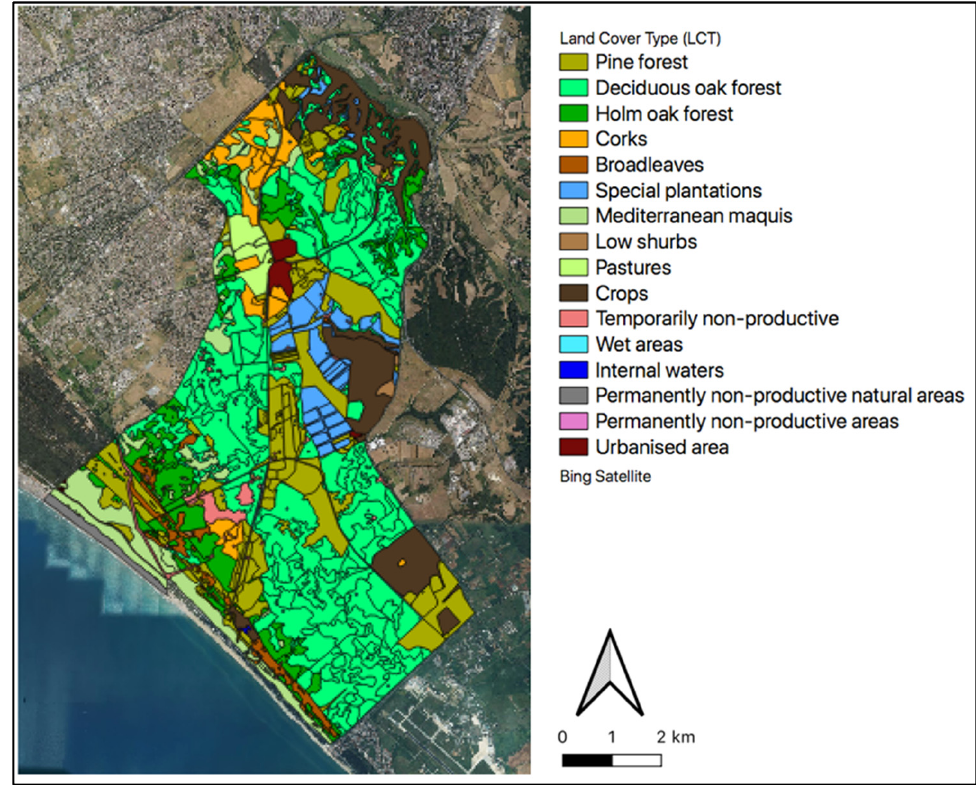
Figure 1. Vegetation map of the presidential Estate of Castelporziano, colored contours represent homogeneous vegetation, each color represent one Land Cover Type (LCT).